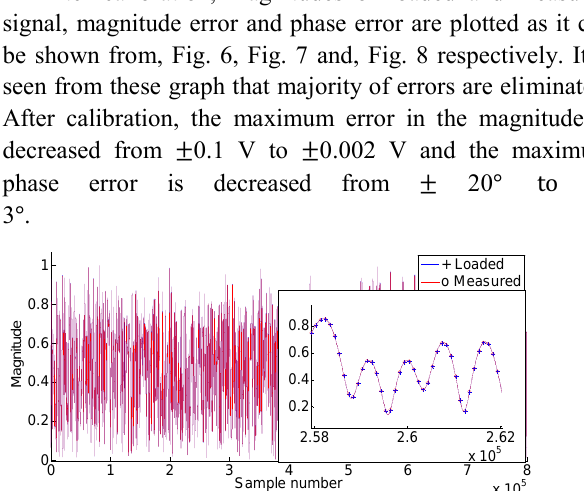
Fig. 6 Magnitude of loaded and time aligned measured